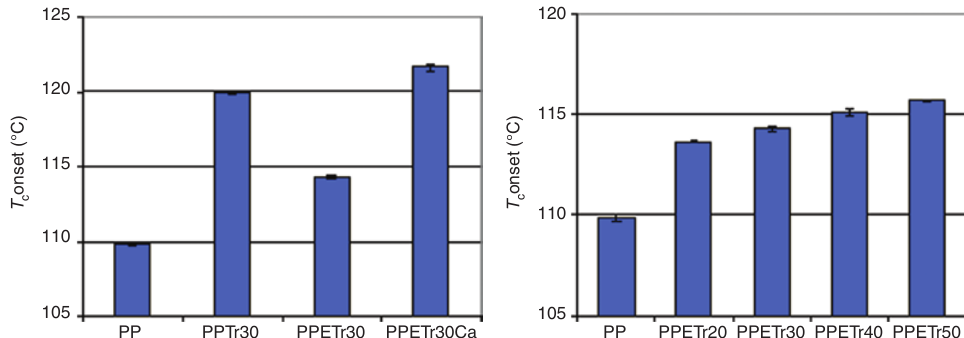
Figure 7 Crystallization temperature of PP/triticale composites.